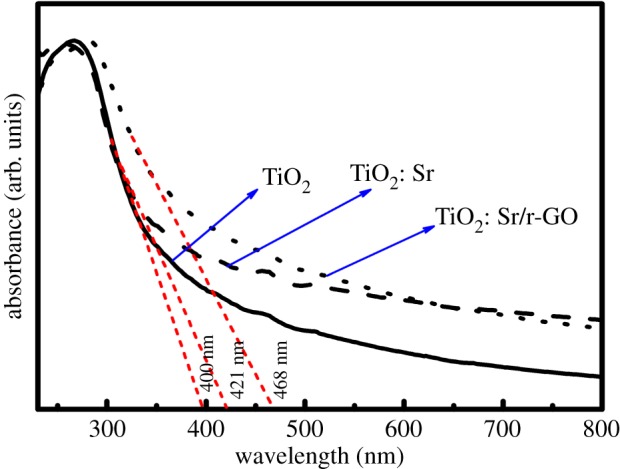
UV–Vis diffuse reflectance spectra of TiO2, TiO2: Sr and TiO2: Sr/r-GO.